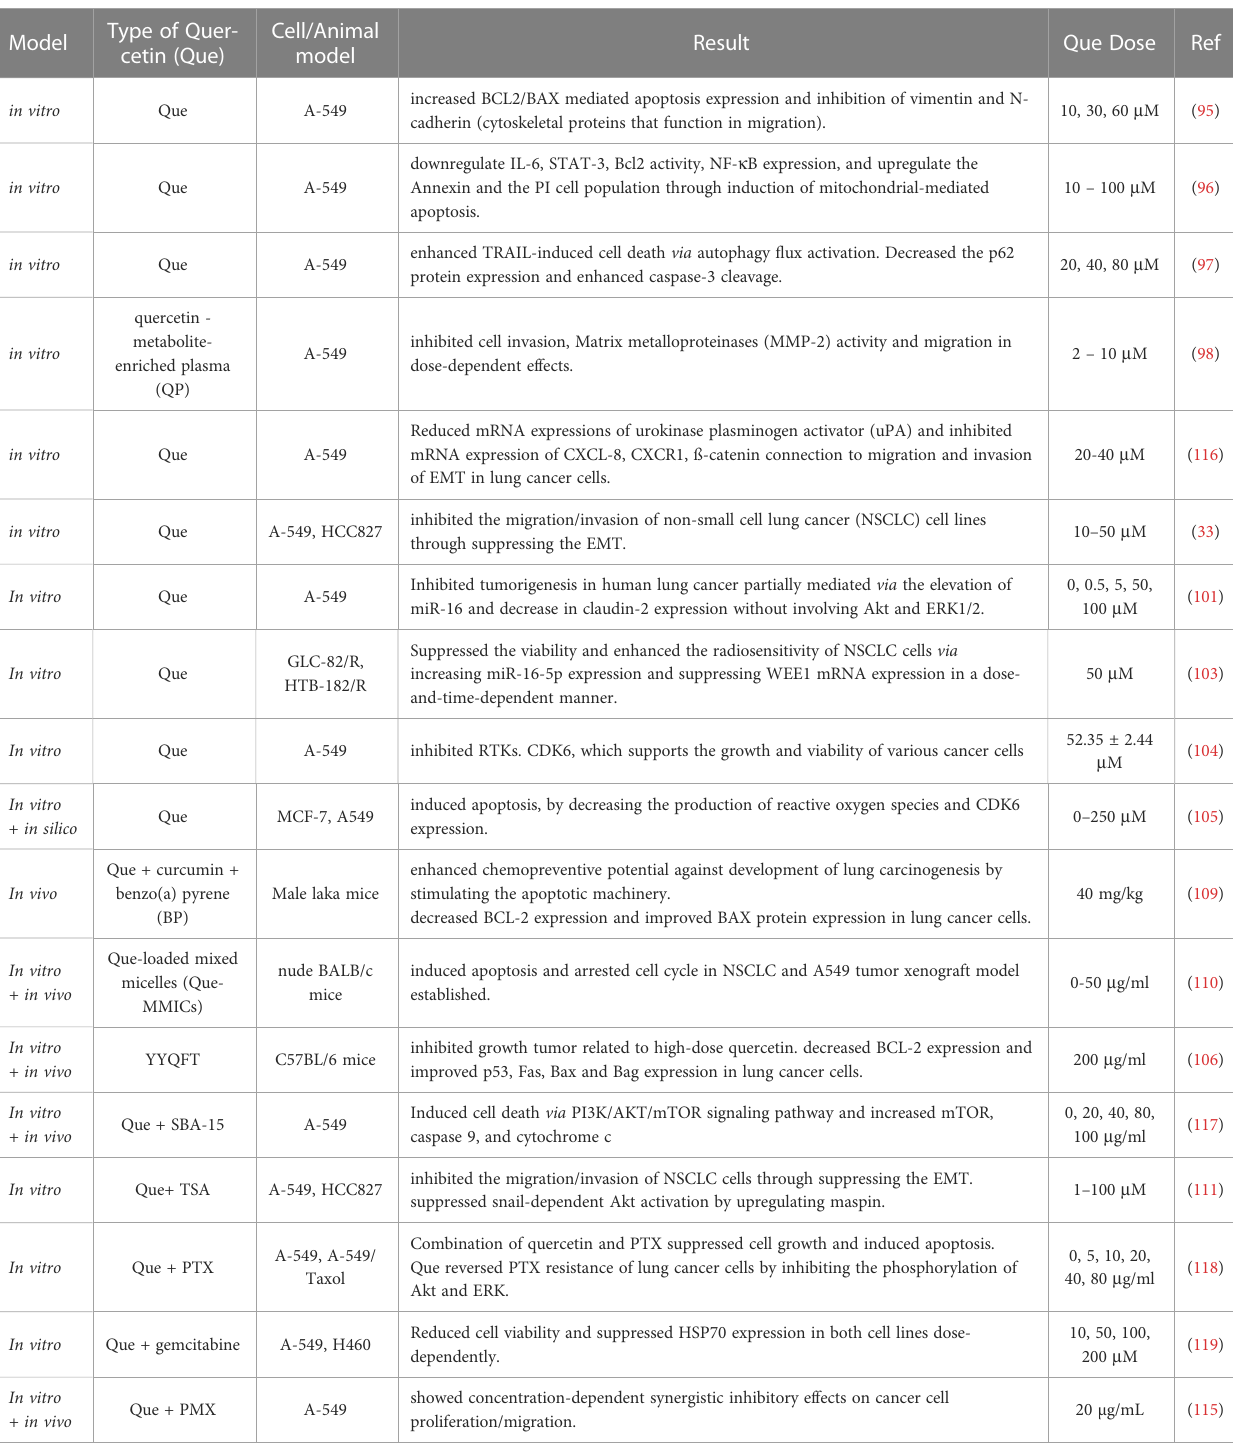
TABLE 2 The therapeutic effects of quercetin on lung